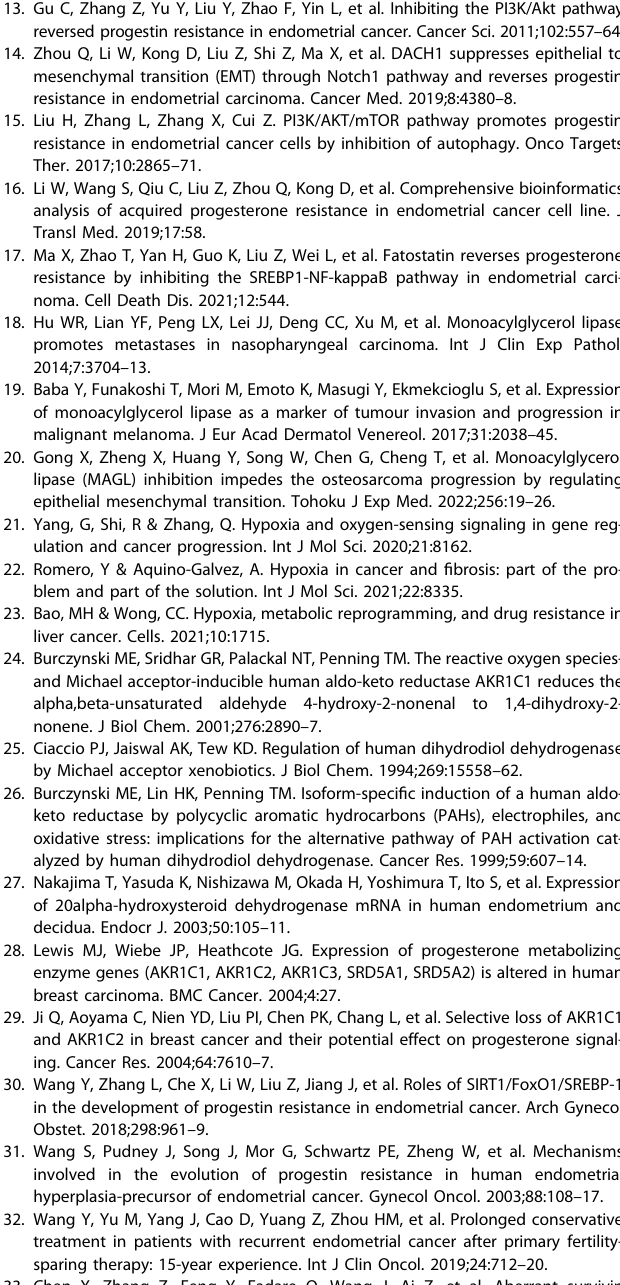
Fig. 7 ABX-1431 enhances the sensitivity of EAC to progesterone by inhibiting MGLL in vivo and vitro. A Expression of MGLL in IshMR cells treated with different concentration and time of ABX-1431. B MTT assay showed the inhibition rate of IshMR cells treated with different concentrations of ABX-1431 and the IC50 of ABX-1431 on IshMR cells. C The effects of MPA and ABX-1431 treatment on cell viability by the CCK8 assay. D Western blot assay showed simultaneous application of ABX-1431 and MPA could inhibit AKR1C1 expression. E The proliferation rate of IshMR treated with MPA or/and ABX-1431 by EDU assay. F The colony-forming ability of IshMR treated with MPA or/and ABX-1431. G The apoptosis of IshMR cells treated with MPA or/and ABX-1431 by fl ow cytometry. H Images of tumors of IshMR cells with MPA, ABX-1431 and combined drug. And the volume and weight of tumor and the body weight of the four groups of mice. I Representative images of IHC staining of MGLL, cleaved-caspase3 and Ki67 in tumor tissues. Scale bar: 10 μ m. All experiments were repeated three times at least. * P <